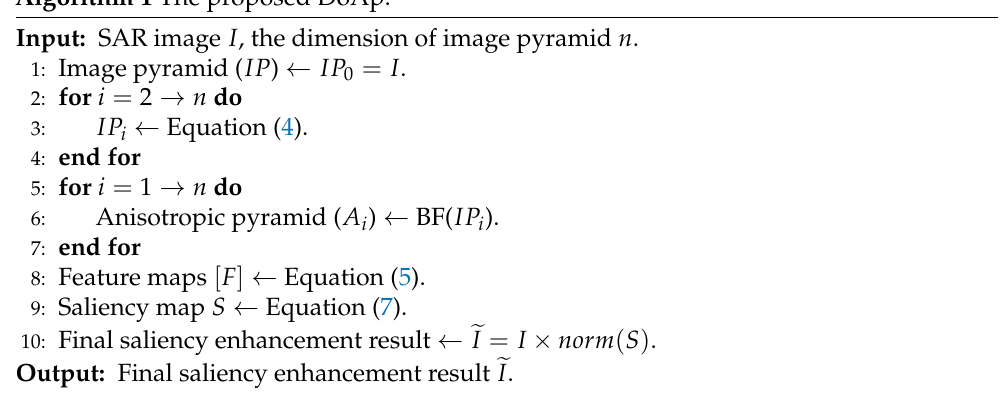
Algorithm 1 The proposed DoAp.